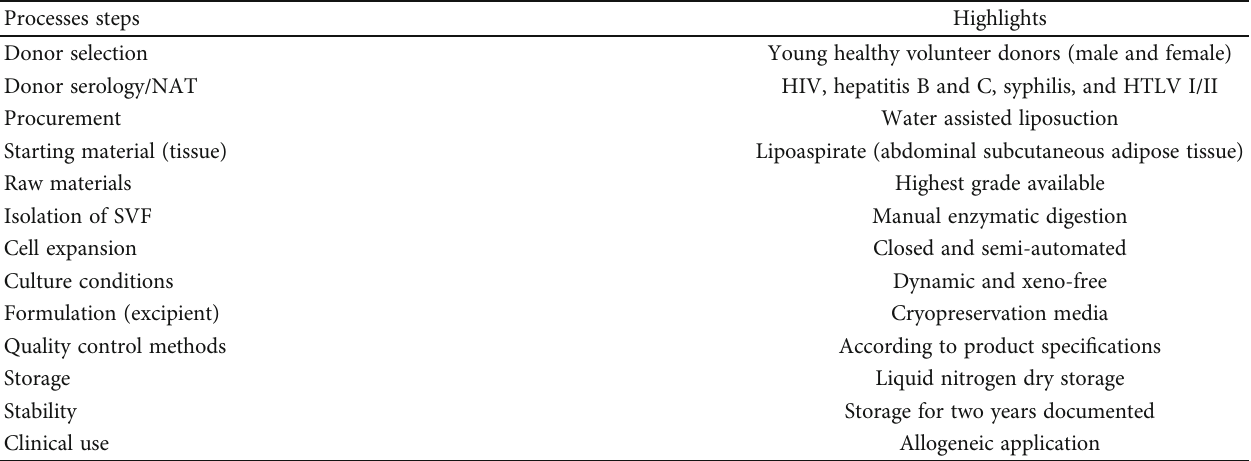
Table 1: Process steps in the production of the ATIMP for allogeneic clinical